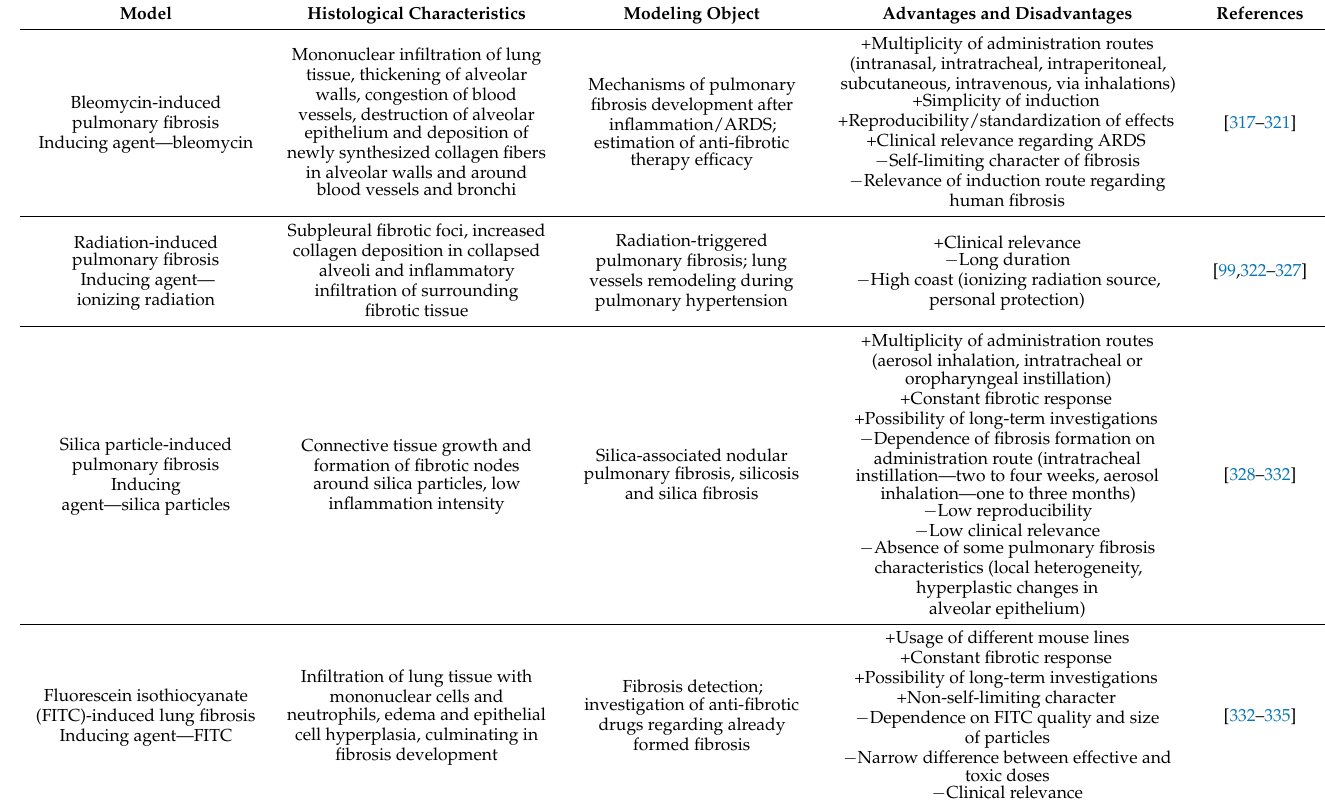
Table 2. Overview of pulmonary fibrosis murine